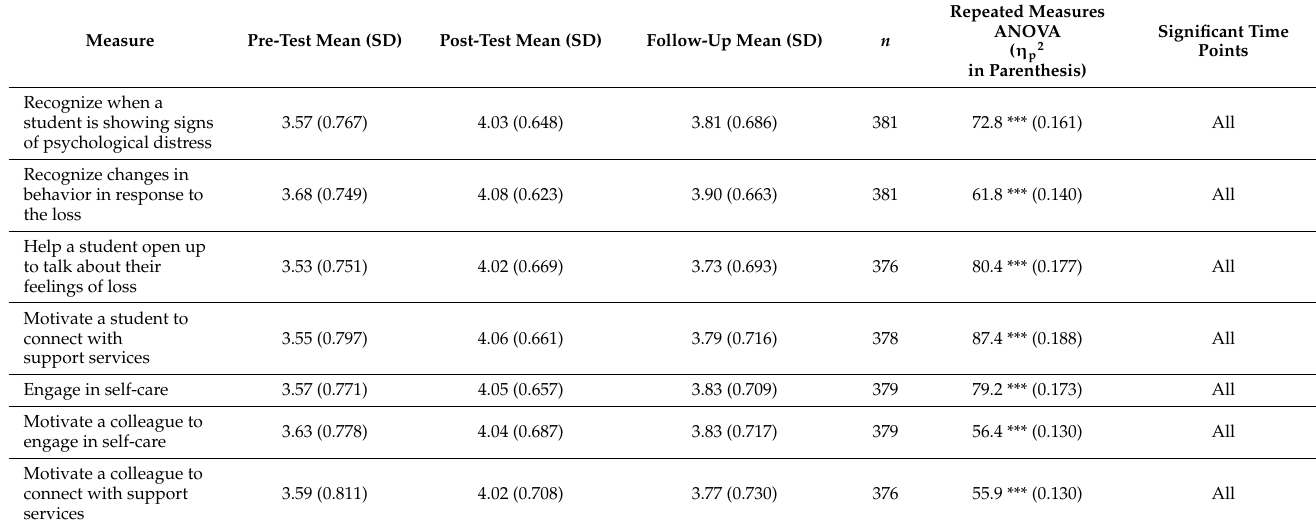
Table 2. In response to a real or possible death in your school or community, please indicate your preparedness